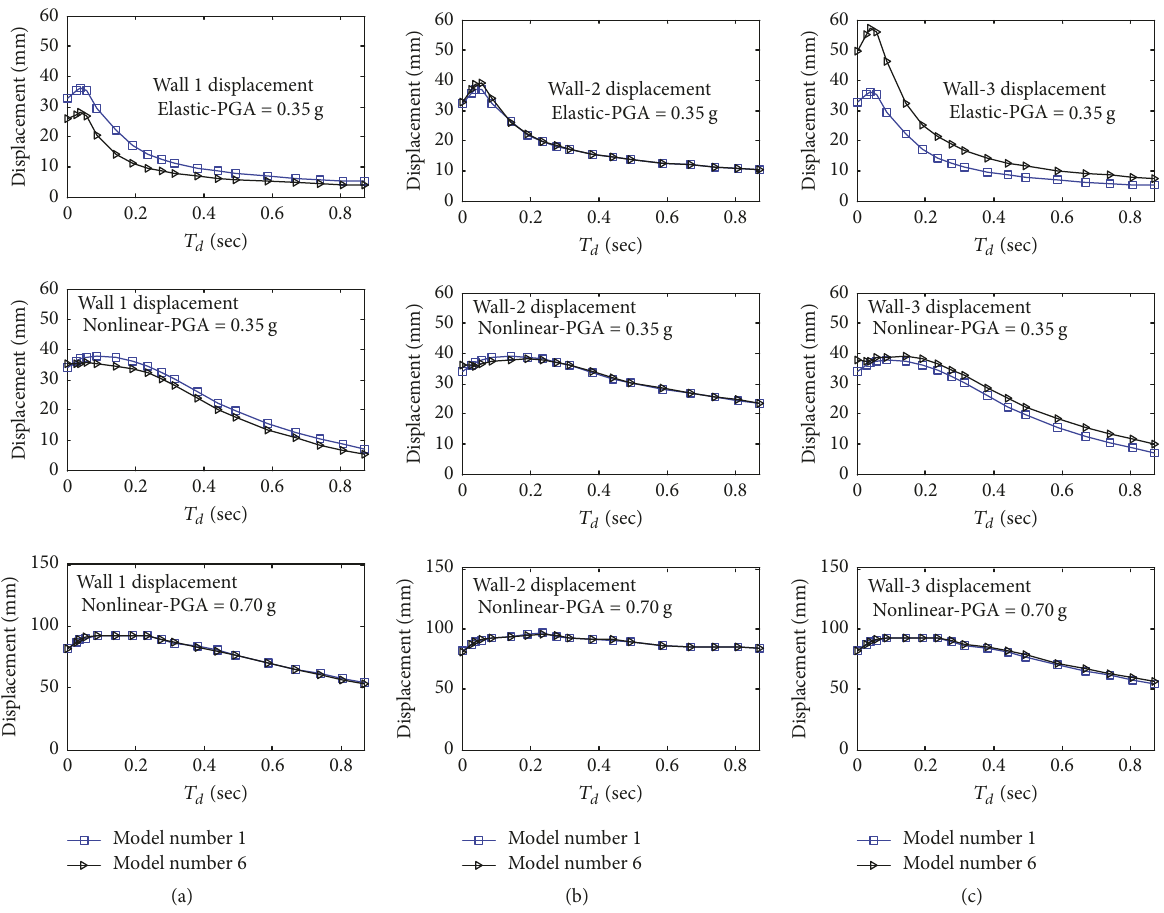
Figure 12: Walls displacements of model 6 in DBE and MCE earthquakes: (a) wall 1 (left side, stiff), (b) wall 2 (central), and (c) wall 3 (right side,